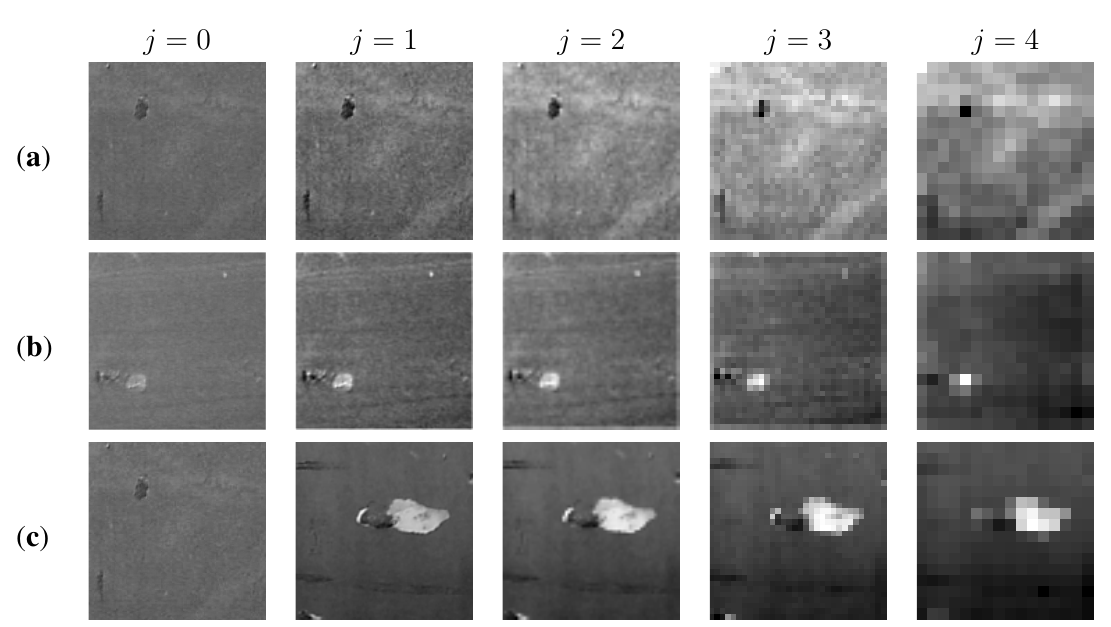
Figure 19. Approximation subimages ( f ( j )